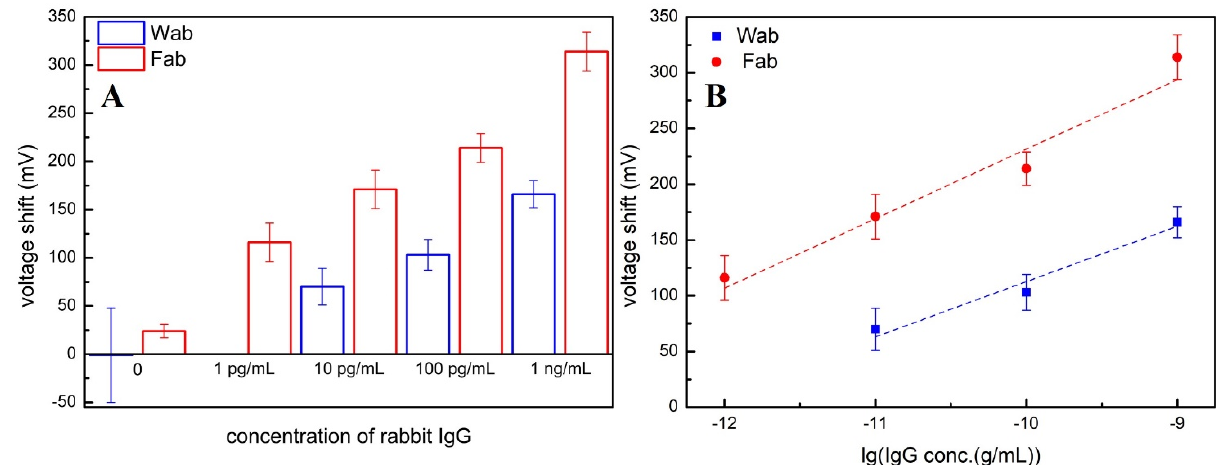
Figure 6. ( A ) Comparison of the signal amplified by R18 (mV) after sensing rabbit IgG at various levels in 150 mM BTP by Wab/PEG-SiNWFETs (blue bars) and Fab/APTES-SiNWFETs (red bars). ( B ) Plot of the voltage shift by R18 versus logarithmic concentrations of rabbit IgG and two respective calibration lines obtained by Wab/PEG-SiNWFETs (blue line) and Fab/APTES-SiNWFETs (red line).